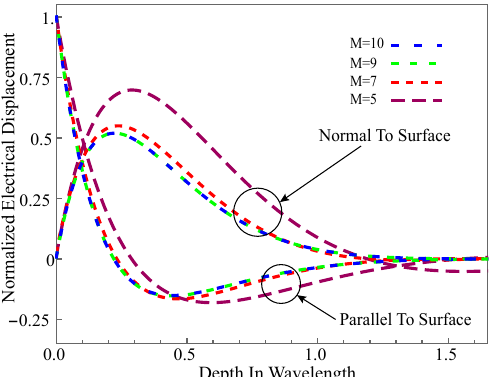
Figure 3. Normalized mechanical displacement amplitude distribution with different M